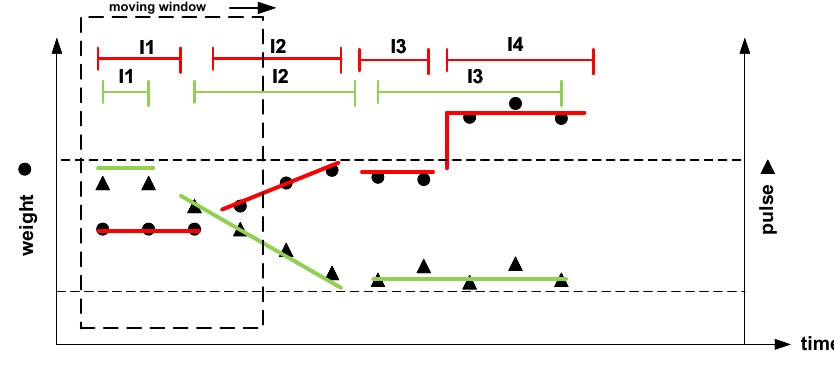
Figure 3. Abstraction of incoming telemedical events by building intervals in Terms of